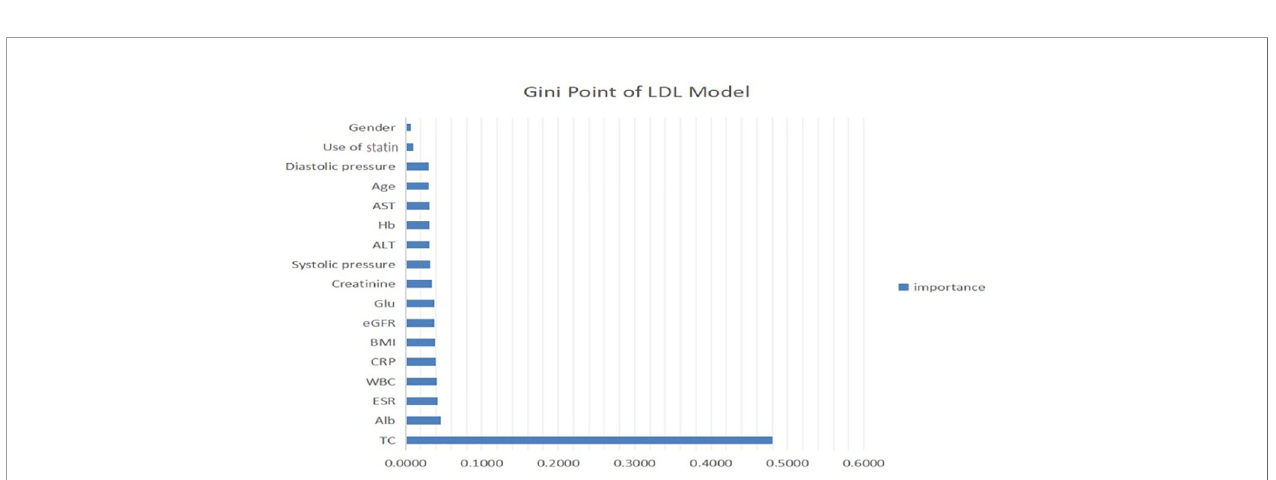
FIGURE 3 | Contribution of predictors of LDL level in CKD patients with micro-in fl ammatory. ALT, serum alanine transaminase; AST, serum aspartate transaminase; Alb, serum albumin; TC, total cholesterol; Glu, blood glucose; Hb, haemoglobin; ESR, erythrocyte sedimentation rate; BMI, body mass index; WBC, white blood cells; hsCRP, hypersensitive C-reactive protein; eGFR, estimated glomerular fi ltration rate.